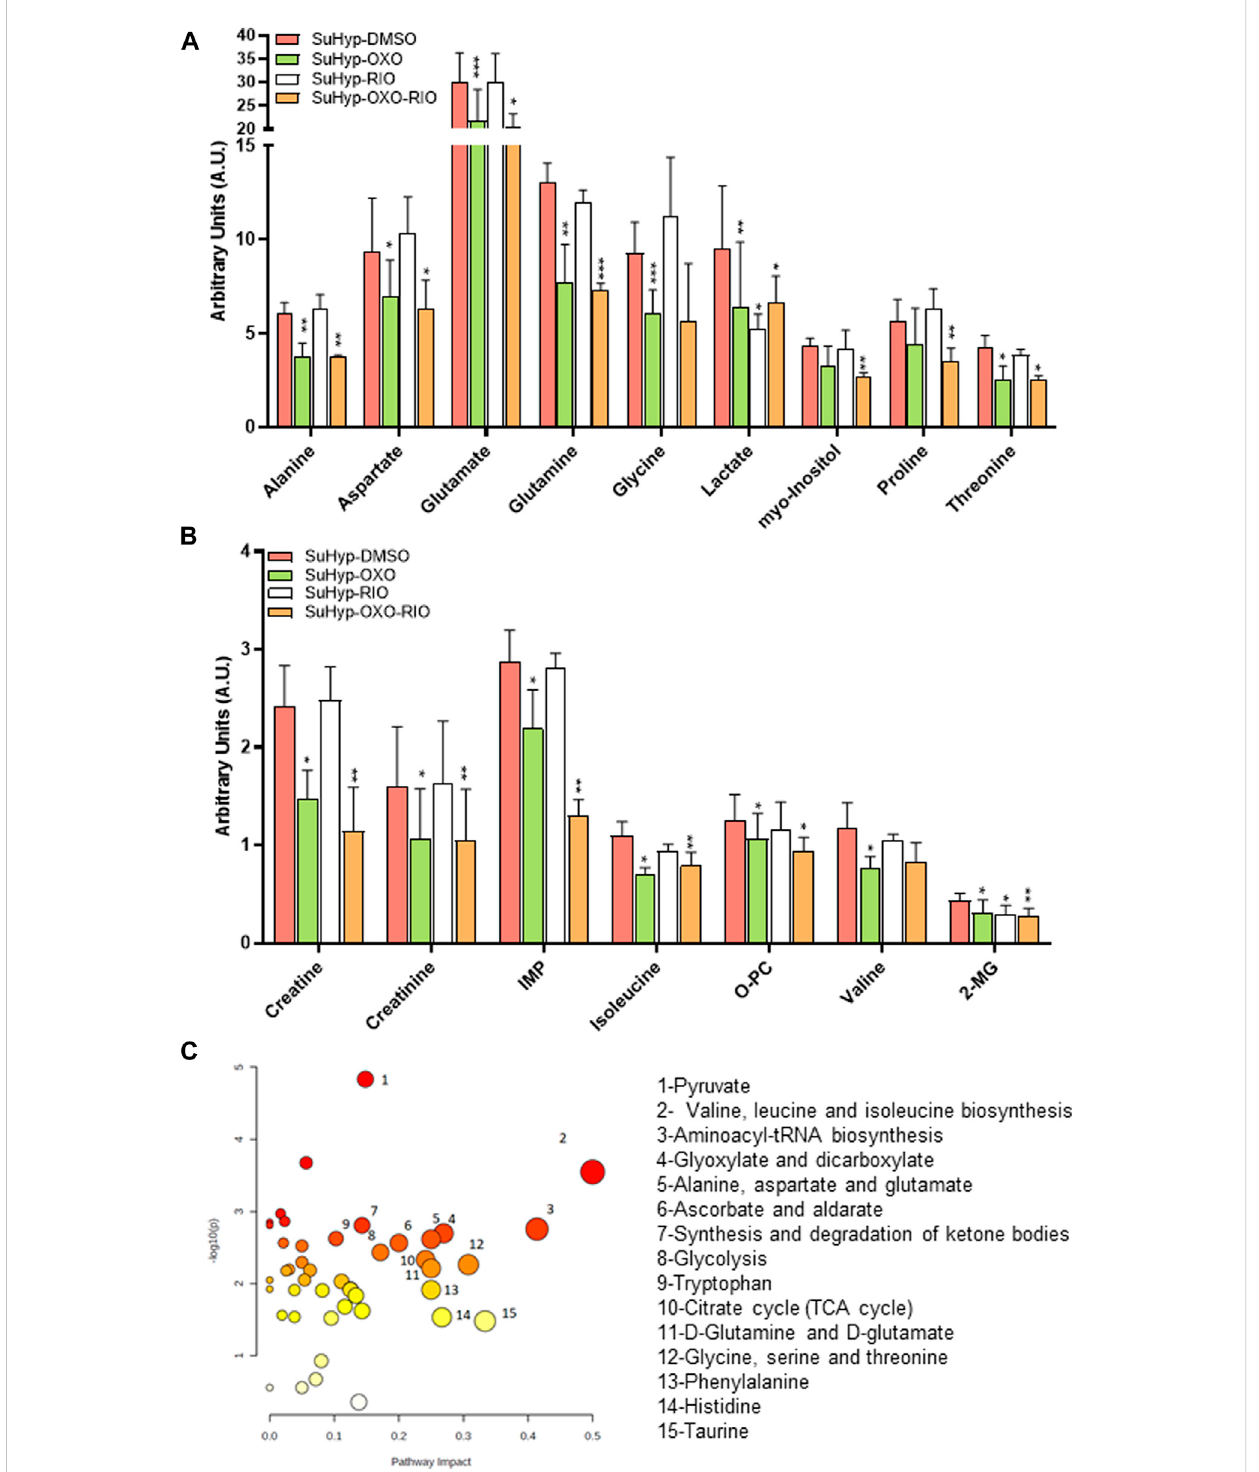
FIGURE 8 Exvivo treatmentwith5-z-7oxozeaenolattenuatesthemetabolicreprogramminginculturedpulmonaryarterysmoothmusclecells(PASMCs)from SuHyprats. (A,B) Metabolomicpro fi lingofcellextractsshowingthequanti fi cationofmetabolites signi fi cantlyalteredinPASMCsisolatedfromSuHyprats and treated with vehicle (DMSO), 5Z-7-oxozeaenol (OXO; 1 µM), riociguat (RIO; 1 µM) or both drugs combined (OXO + RIO). Statistical signi fi cance was determinedusingaBonferroni-correctedStudent ’ st-test(* p < 0.05 versus normoxia+vehicleand# p < 0.05 versus SuHyp+vehicle). (C) Metabolic pathway analysis of the set of metabolites found to be signi fi cantly dysregulated following treatment with the combination of OXO and RIO on PASMCs isolated from SuHyp rats. Y -axis represents the statistical p values from enrichment analysis, and the X -axis represents the pathway impact value calculated from pathway topology analysis. The node colors represent the p -values (lowest: light yellow; highest: dark red) and the node radius indicate the pathway impact values. Dysregulated metabolic pathways are